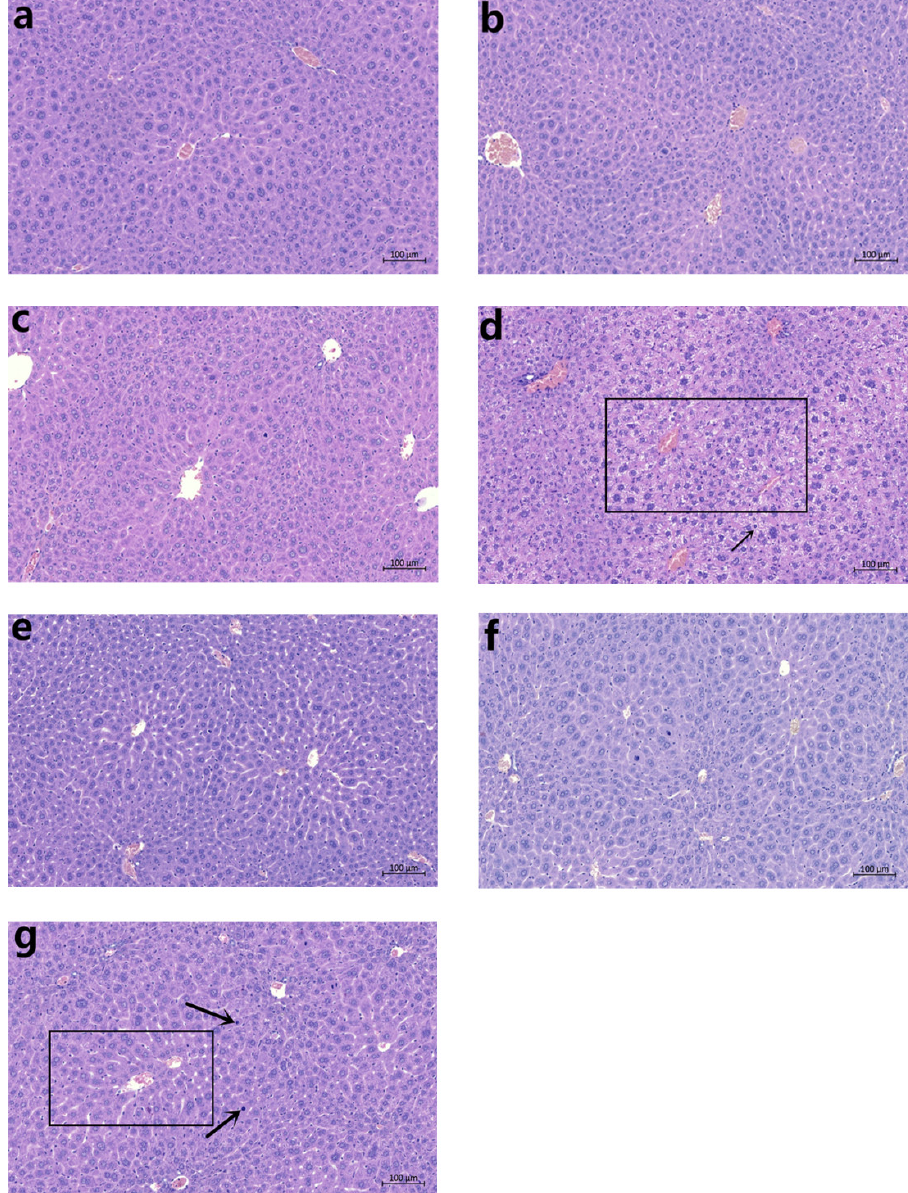
Figure 1. Histopathological examination of the livers of mice treated with the control ( a ); CDAE 2.3 g/kg ( b ); CDAE 4.6 g/kg ( c ); CDAE 9.2 g/kg ( d ); CDEE 2.3 g/kg ( e ); CDEE 4.6 g/kg ( f ); and CDEE 9.2 g/kg ( g ) for 28 days. (HE, 300×).